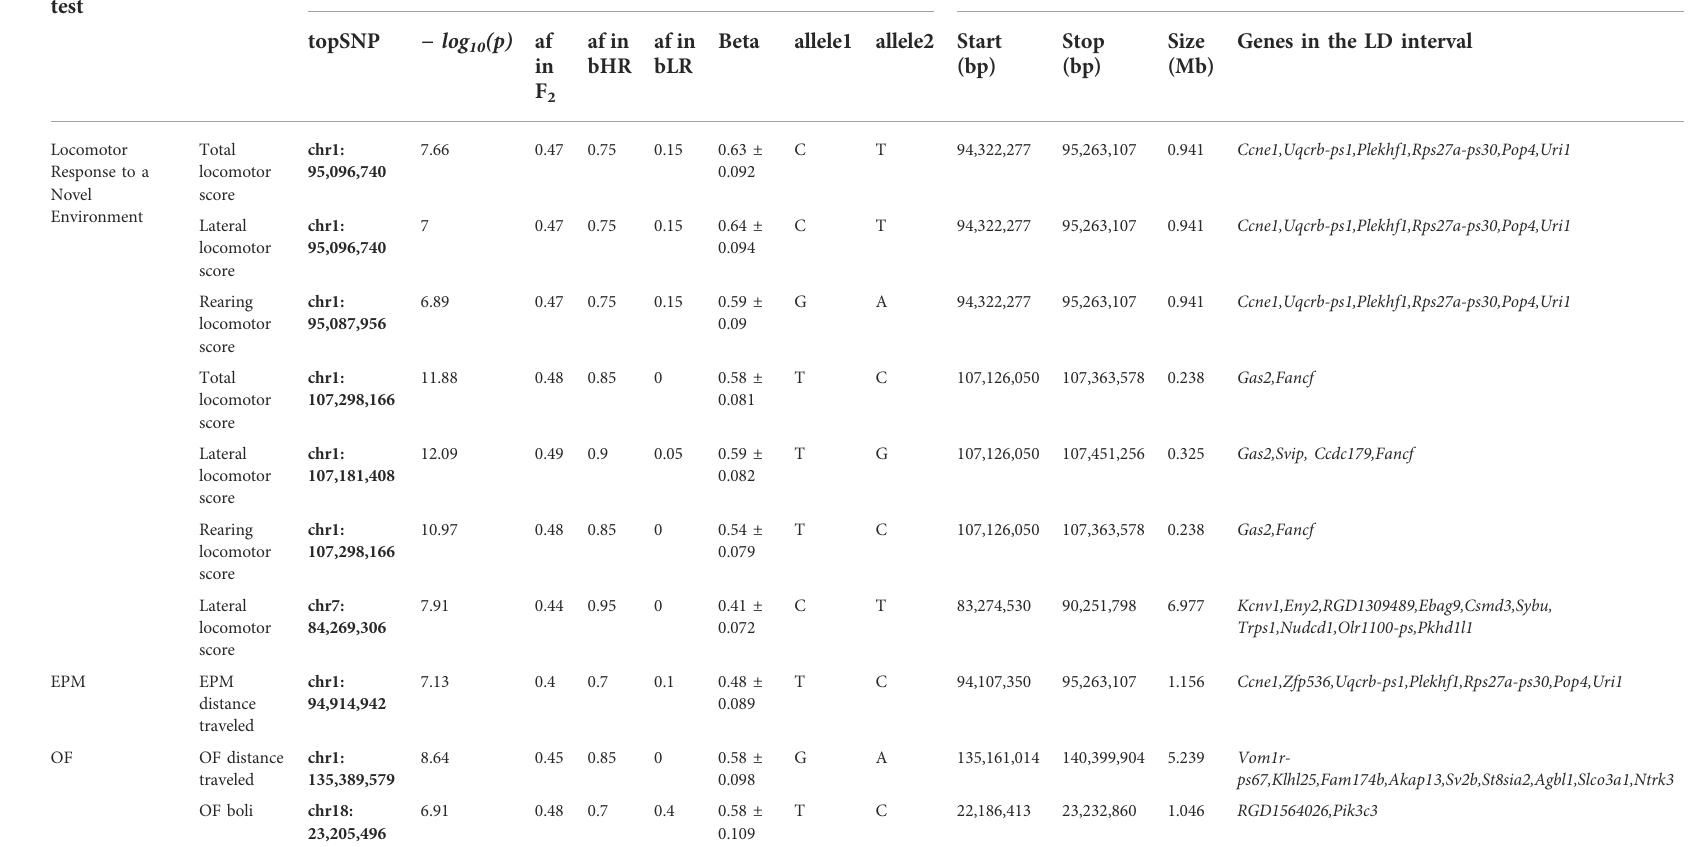
TABLE 4 Summary of